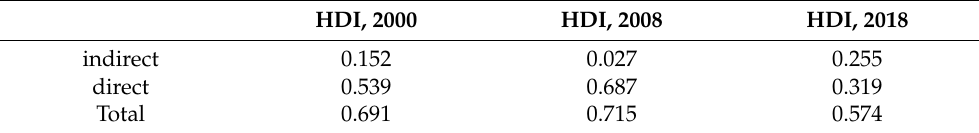
Table 4. The roles of the direct and indirect paths in explaining the HDI (standardized β coefficients). HDI, 2000 HDI, 2008 HDI, 2018 indirect 0.152 0.027 0.255 direct 0.539 0.687 0.319 Total 0.691 0.715